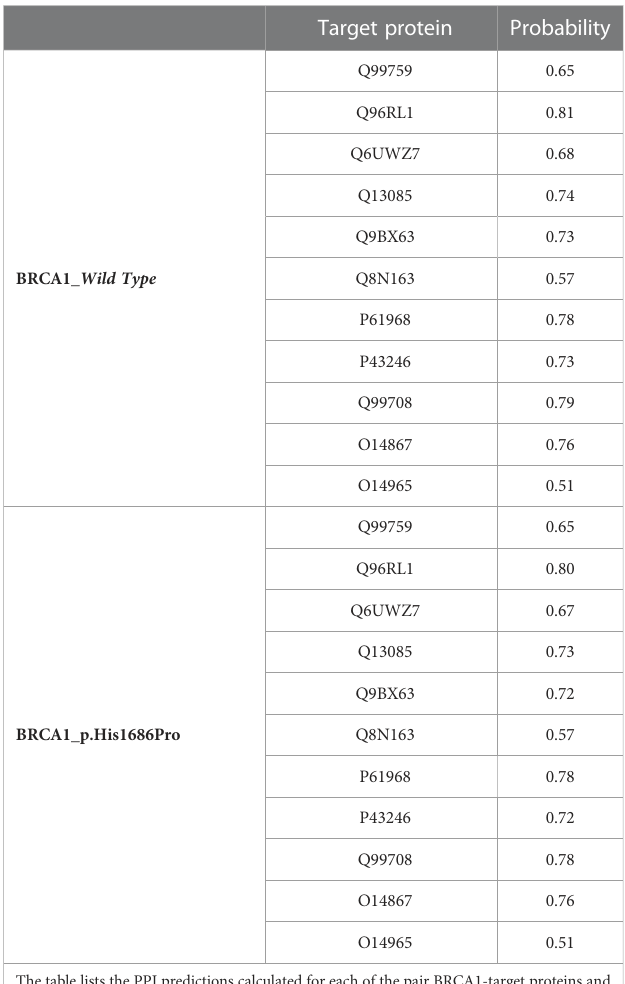
The table lists the PPI predictions calculated for each of the pair BRCA1-target proteins and BRCA1 p.His1686Pro-target proteins. PPI prediction is expressed as the probability (P) of a given pair to form an interaction. P > 0.5 is assumed to be a valid